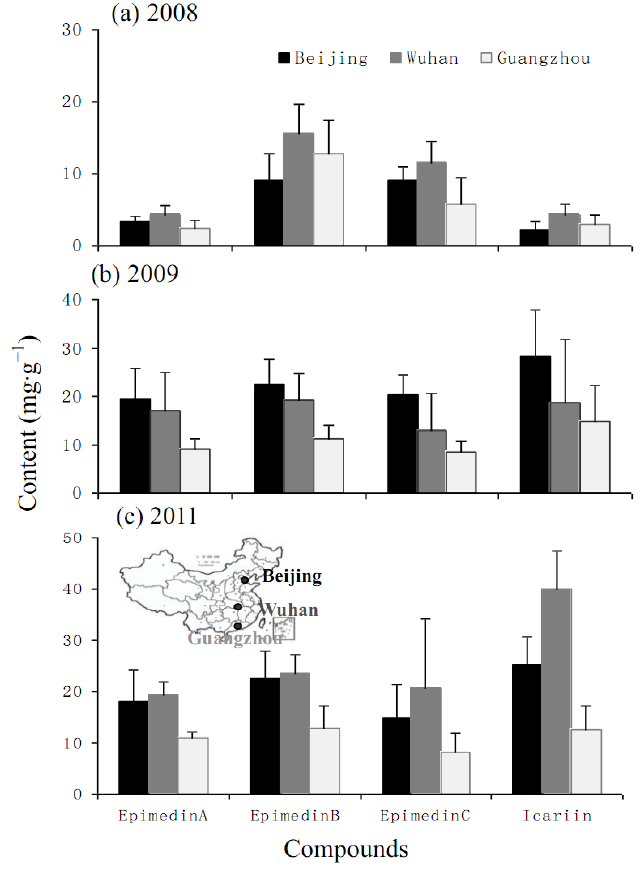
Figure 4. Four flavonoids contents of LT race planted in three gardens (Beijing, light intensity 50–180 μ mol/m 2 /s; Wuhan, light intensity 60–160 μ mol/m 2 /s ; Guangzhou, light intensity 55–170 μ mol/m 2 /s) after one (2008), two (2009) and four years (2011). Bars are standard errors.